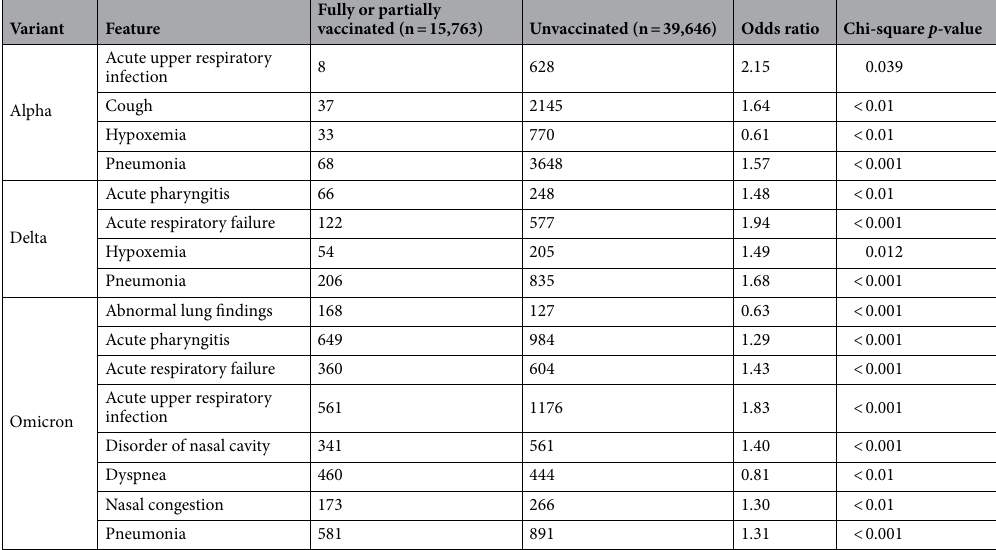
Table 14. Chi-square tests comparing feature significance in any vaccinated versus unvaccinated individuals across the Alpha, Delta and Omicron waves. p -value < 0.05 is